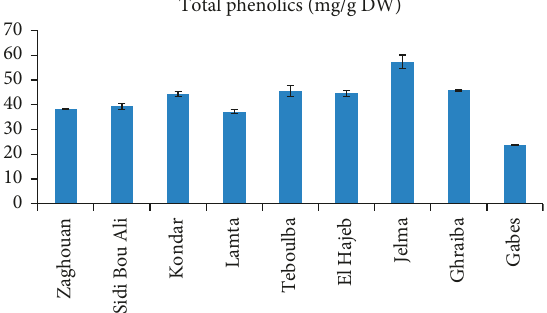
Figure 3: Total phenolic contents in “Chemlali” olive leaf extracts according to the cultivation regions.